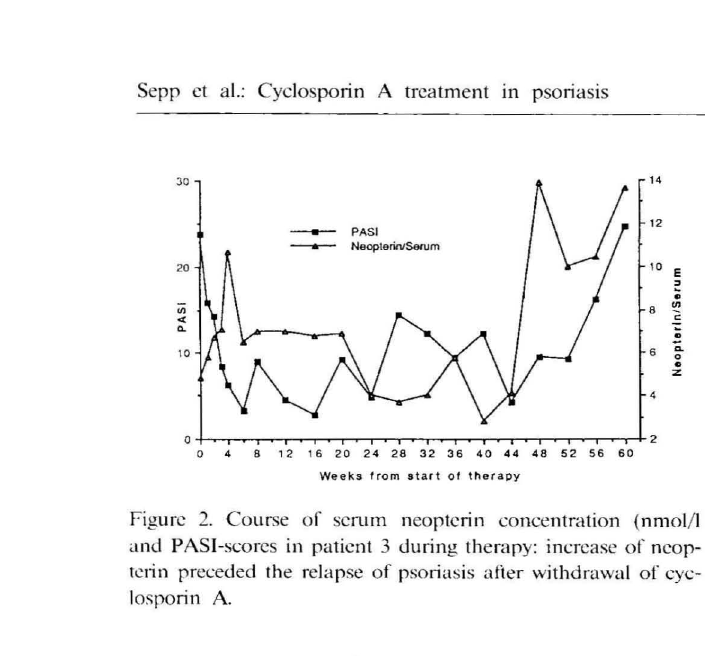
Figure 2. Course of serum neopterin concentration (nmol/l and PASI-scores in patient 3 during therapy: increase of neop telin preceded the relapse of psoriasis alier withdrawal of cyc losporin A.